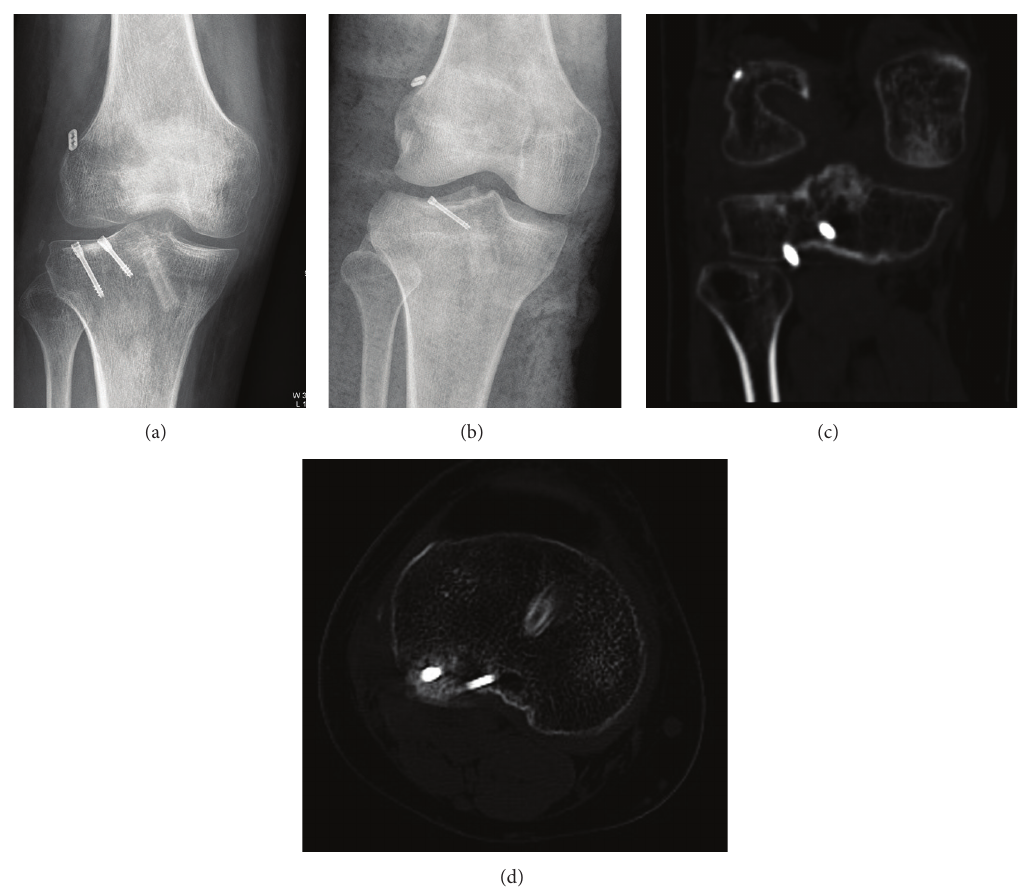
Figure 3: X-ray images of the knees after the operation. In the first patient (a), button steel was used at the femoral site for ACL reconstruction and two lag screws were used for posterolateral tibial fracture fixation. In the second patient (b), similar procedure to that for the first patient, but only one screw, was used. (c and d) The CT scans in patient one showed the tibial plateau fracture was well reduced and